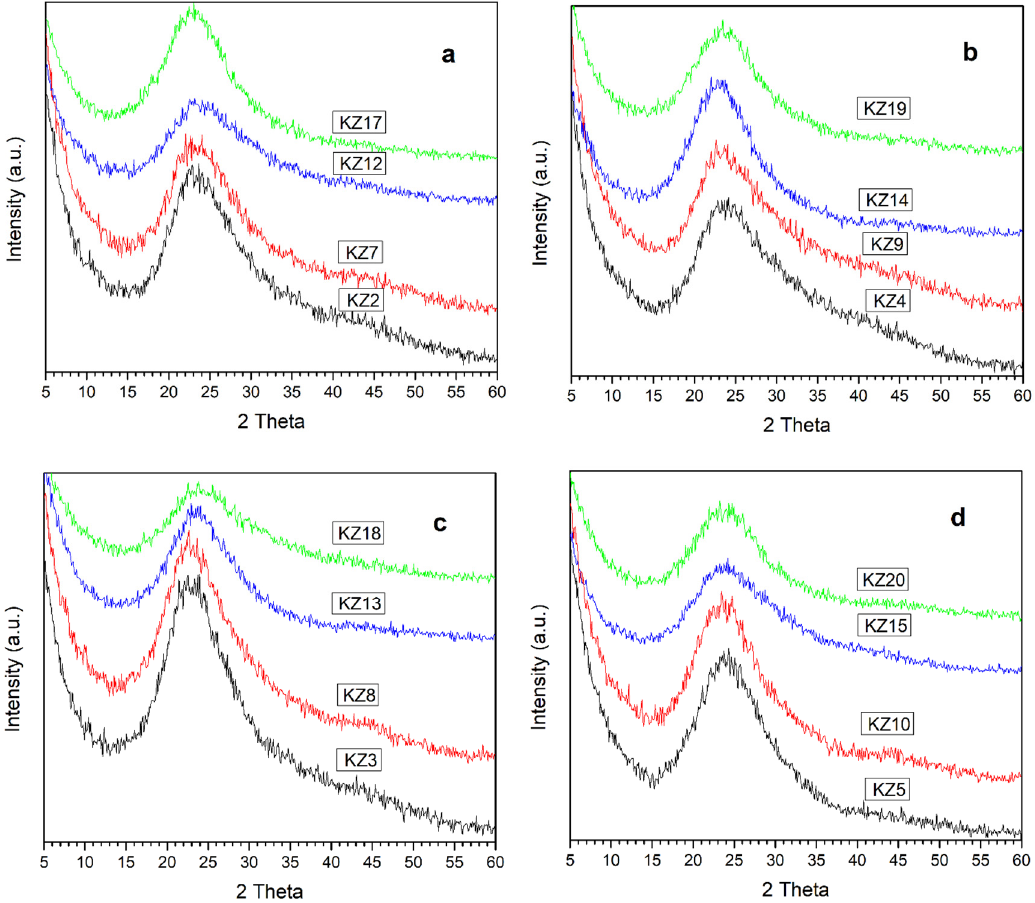
Figure 7. XRD diagram of all synthesized silica-based solids. ( a ) All solids synthesized with 50% orange peel. ( b ) All solids synthesized with 50% lemon peel. ( c ) All solids synthesized with 25% orange peel. ( d ) All solids synthesized with 25% lemon